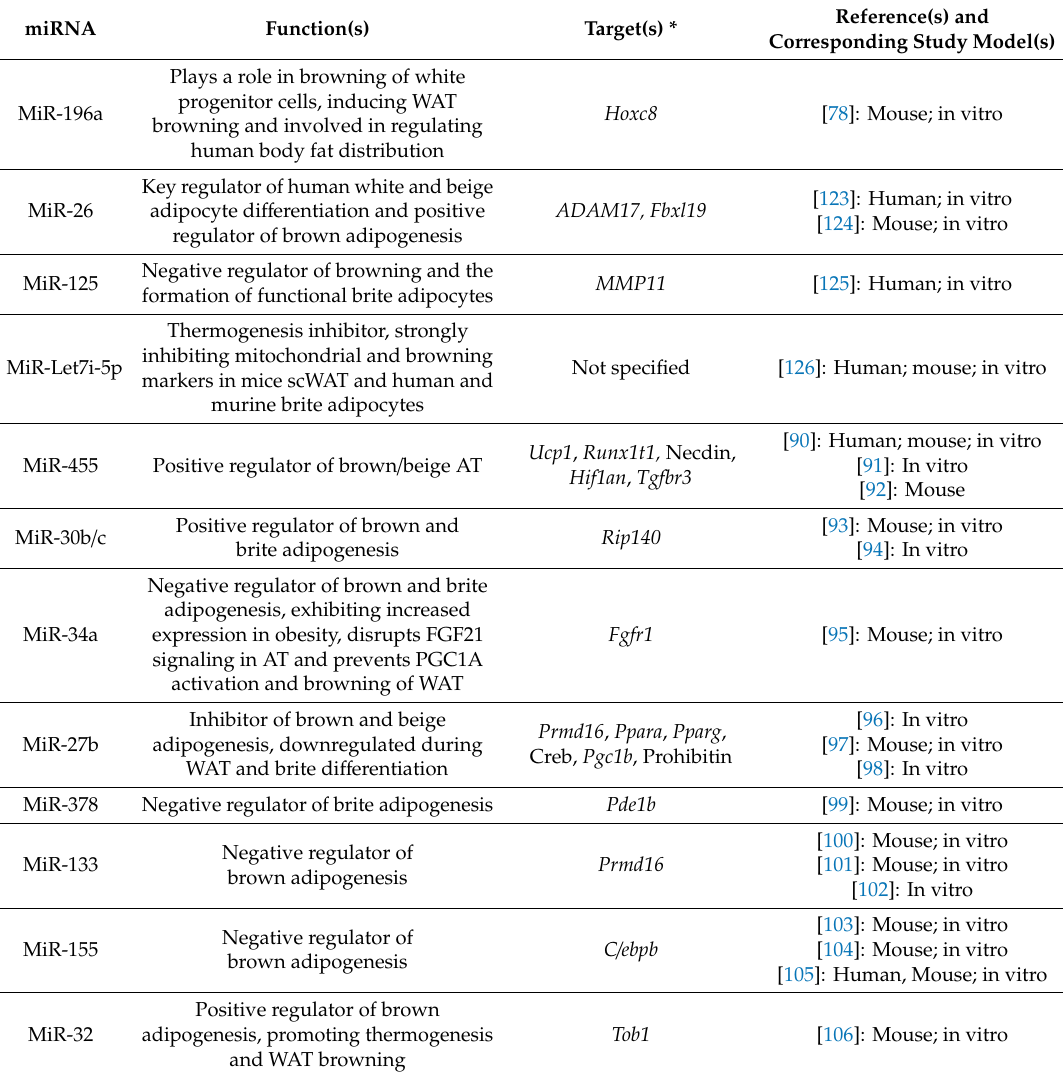
Table 2. Selected key microRNAs (miRNAs) and their reported e ff ects in brite (beige or brown-in-white) adipose